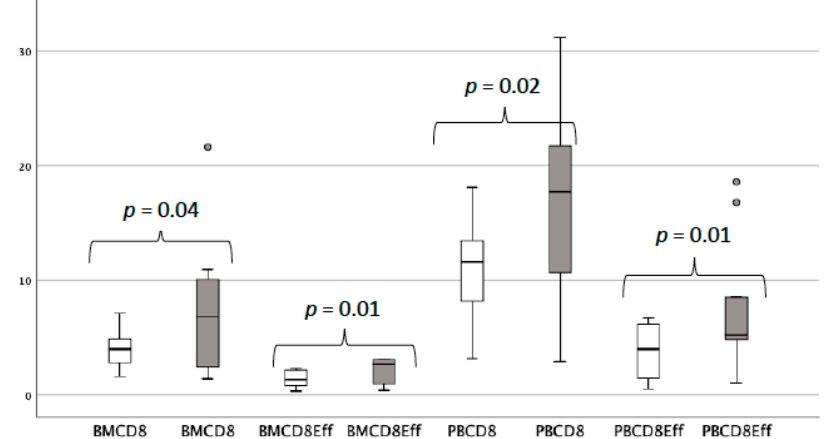
Figure 2. Percentages of the populations di ff erently represented in patients with and without detectable disease by next generation flow at enrollment. White boxes represent the values obtained in minimal residual disease (MRD)-positive patients, whereas gray boxes correspond to MRD-negative patients.